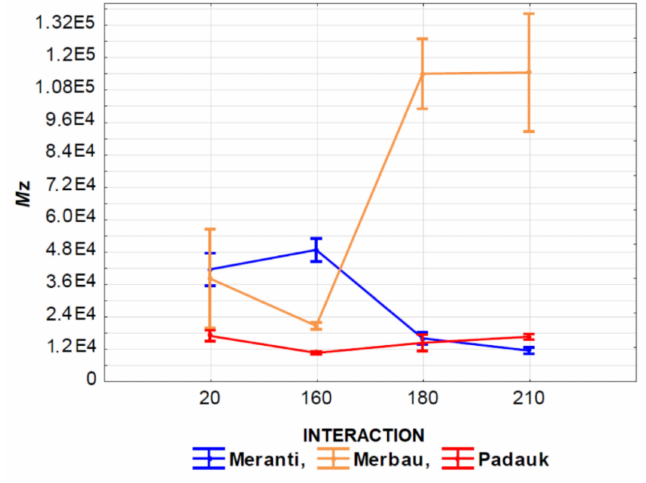
Figure 9. The effect of thermal modification temperature and wood species on Z average molecular weight ( M z ) values.